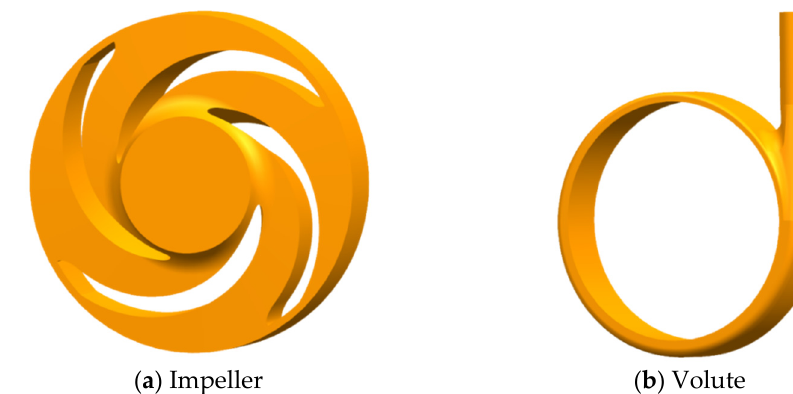
Figure 1. ( a , b ) Three-dimensional models of the flow domain.